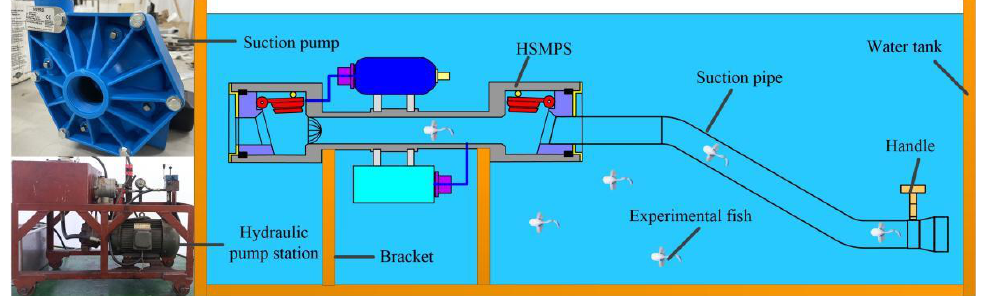
Figure 11. Principle diagram of suction test.